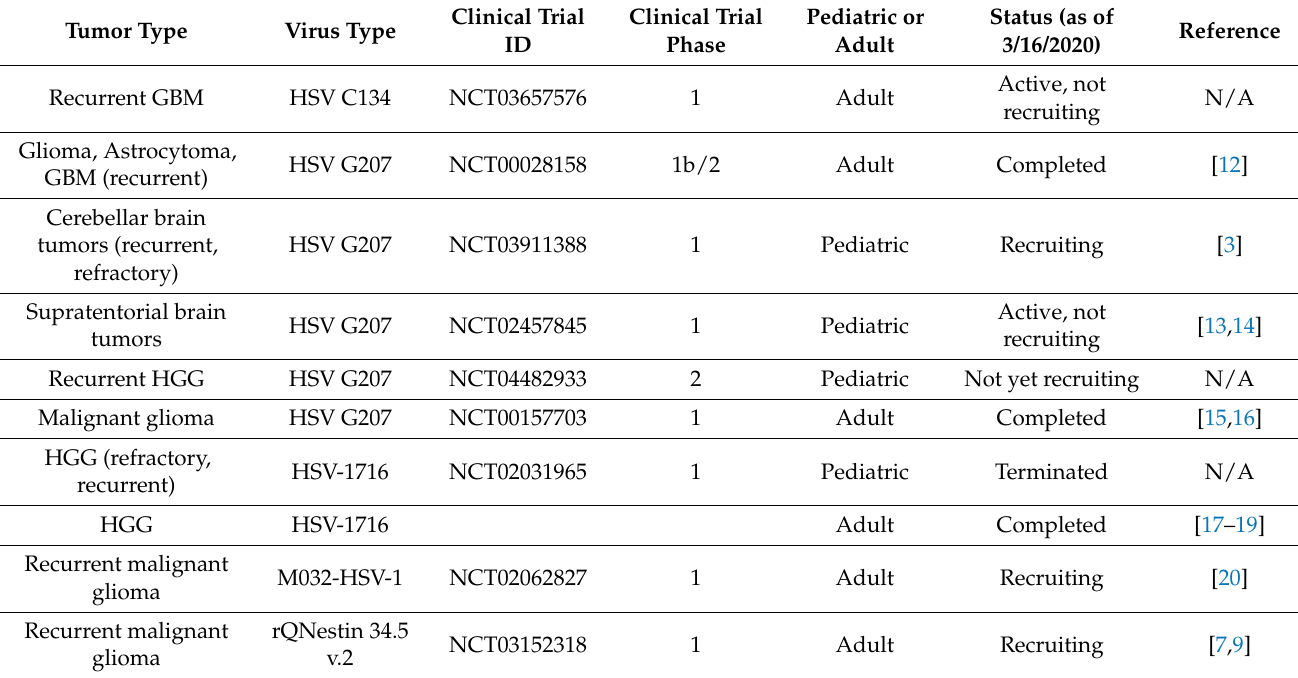
Table 1. Ongoing and past oHSV clinical trials in brain tumor patients registered on clinicaltrials.gov (accessed on 16 March